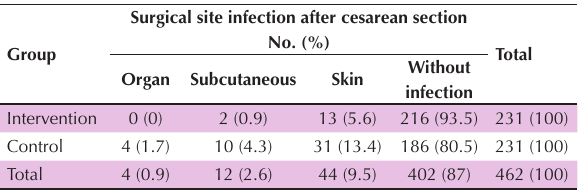
Table 2. Comparison of the frequency of superficial infection at the surgical site after cesarean section by group Surgical site infection after cesarean section No. (%) Group Total Without Organ Subcutaneous Skin